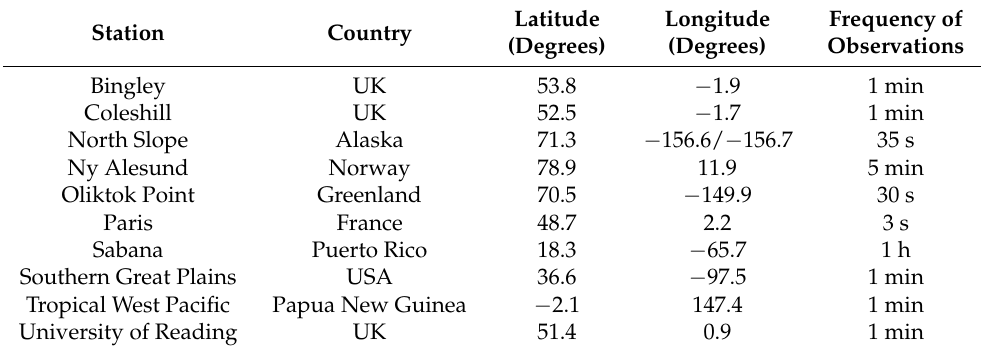
Table 6. Ground station locations of in situ ceilometer data used to validate the Bayesian cloud detection applied to different satellite sensors [39–45]. The North Slope of Alaska station has two longitudes as the station location has moved within the data record.